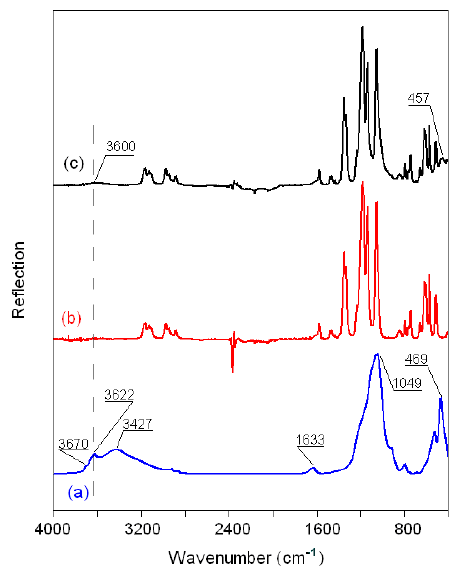
Figure 8. FTIR spectra of ( a ) MMT K10, ( b ) BMImNTf 2 , and ( c ) MMT K10/BMImNTf 2.